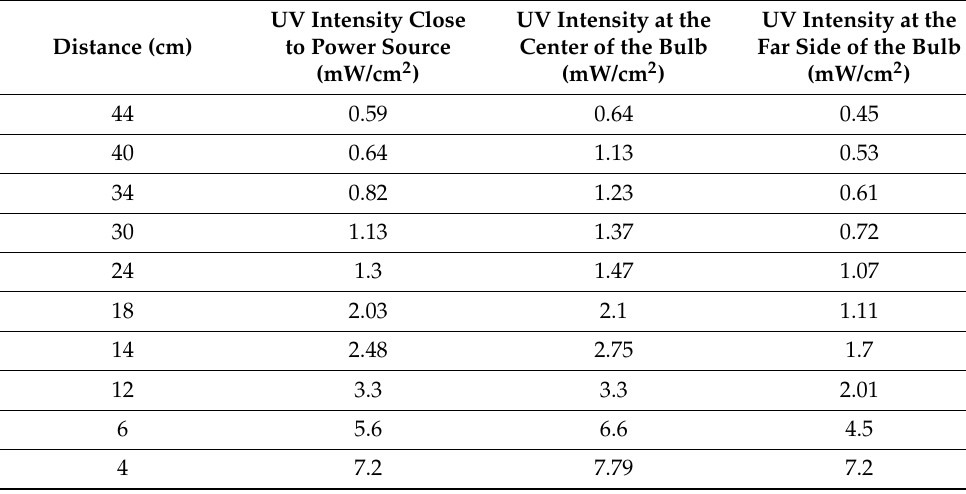
Table A2. UV intensity based on the distance from the UV